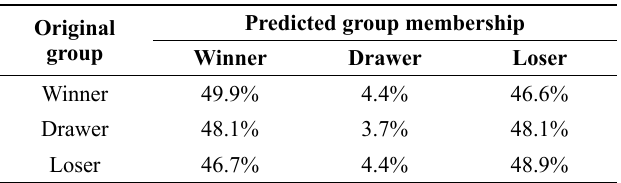
Table 2. Teams’ classification by match status and according to discriminant function analysis